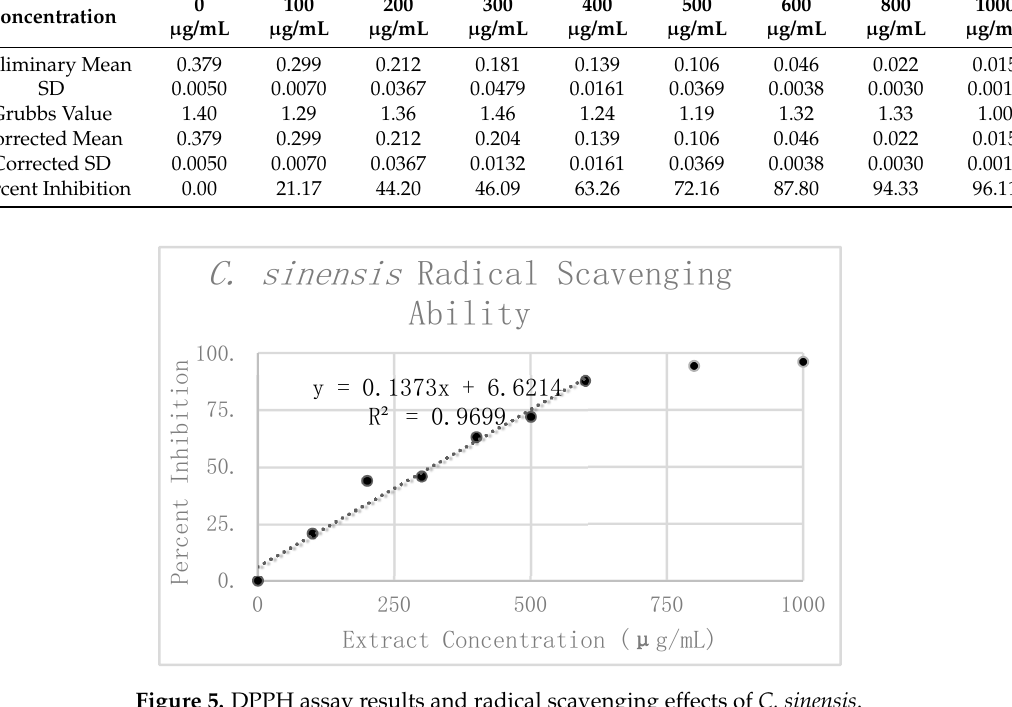
Figure 5. DPPH assay results and radical scavenging effects of C. sinensis .